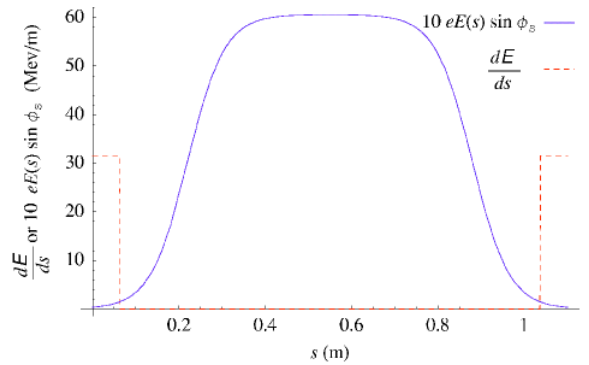
FIG. 3. (Color) The lattice functions b 6 (cid:2) s (cid:3) , over one period.